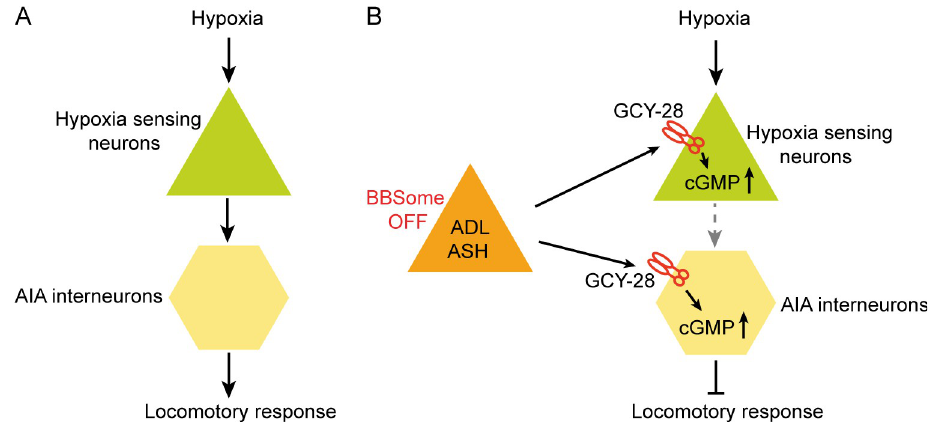
Fig 9. Schematic representation of the main discoveries. (A) Multiple sensory neurons are involved in the sensation of acute hypoxia. AIA interneurons are one of the major components in the downstream circuits of acute hypoxia response. (B) ADL and ASH neurons are not directly required for acute hypoxia sensing, but they play a modulatory role in locomotory responses to acute hypoxia. When BBSome is disrupted, signals from ADL and ASH neurons overactivates the receptor guanylate cyclase GCY-28 to generate excessive amount of cGMP in the hypoxia sensing circuit and inhibits acute hypoxia responses.